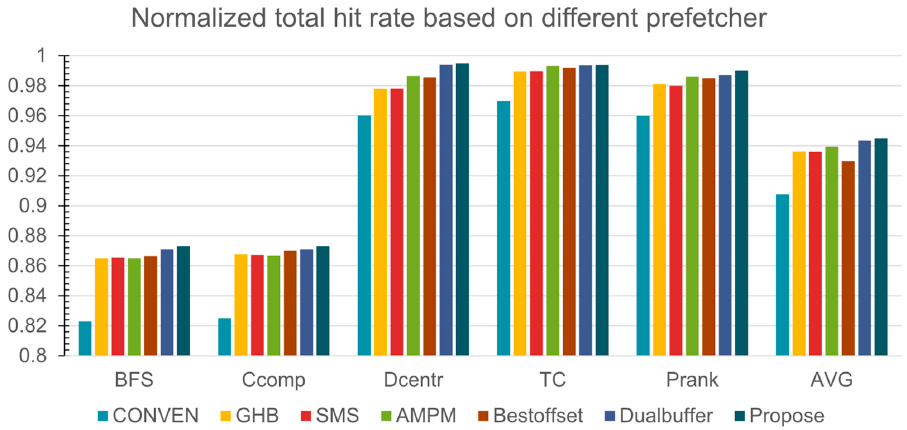
Figure 13. The total hit rate for graph